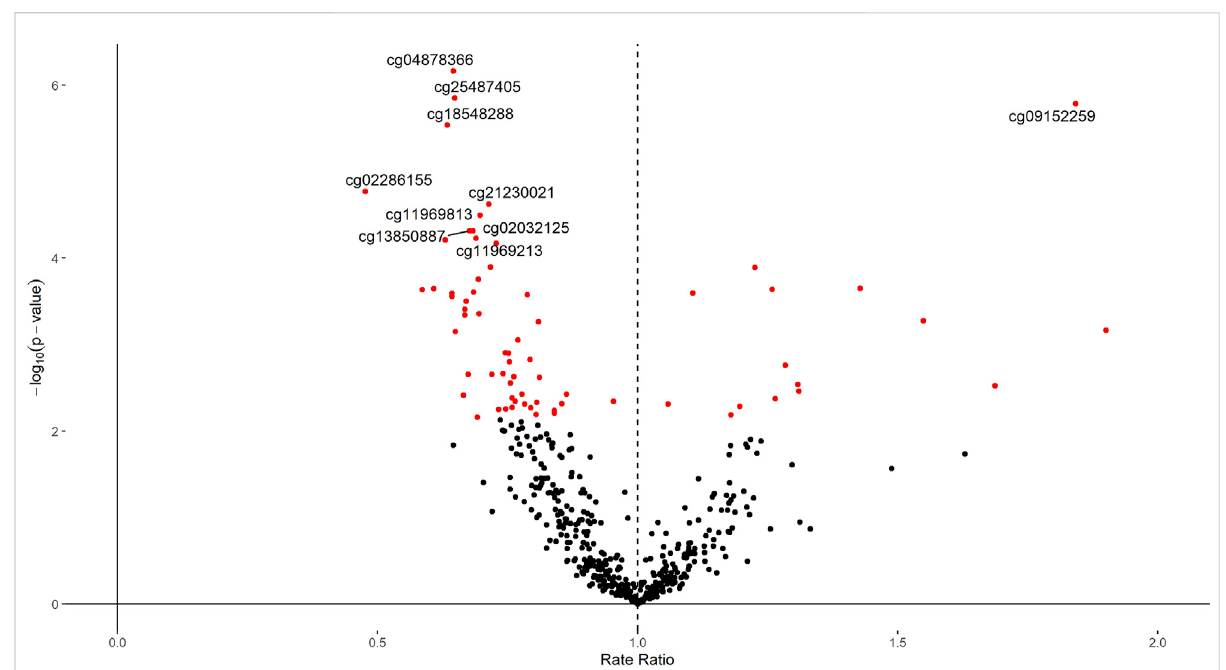
FIGURE 5 Volcano plot of the p -value and β coef fi cient for the association between 483 putative BMI-associated CpGs and the SMFQ score. The linear mixed-effect model is adjusted for sex and age of child, physical activity at the age of 5 years, age of mother at birth, birthweight, mother ’ s pre- pregnancy BMI, average weekly family income at 7, mother ’ s highest education quali fi cation, CD4T, Bcell, CD8T, Gran, Mono, NK as fi xed effect and chip and position bead array as random effects. The red dots are theCpGs with FDR < 0.05. The vertical black dashed line indicates the rate ratio at 1. The vertical axis is the signi fi cance ( p -value) on a log10 scale, and the horizontal axis is the beta